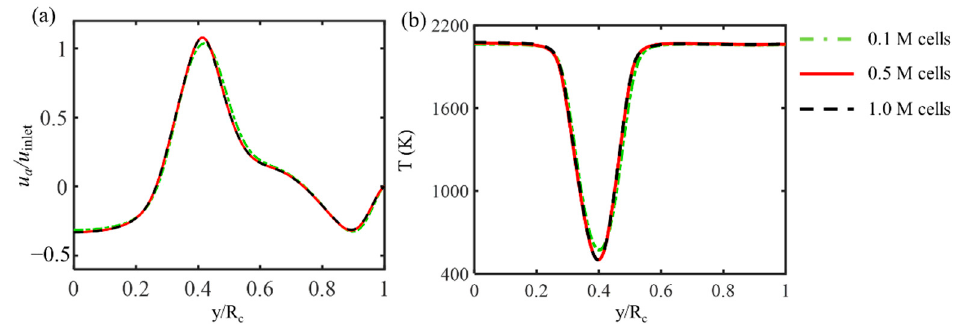
Figure 2. Mesh sensitivity analyses: ( a ) normalized axial velocity profiles and ( b ) temperature profiles at x/R c = 0.5.